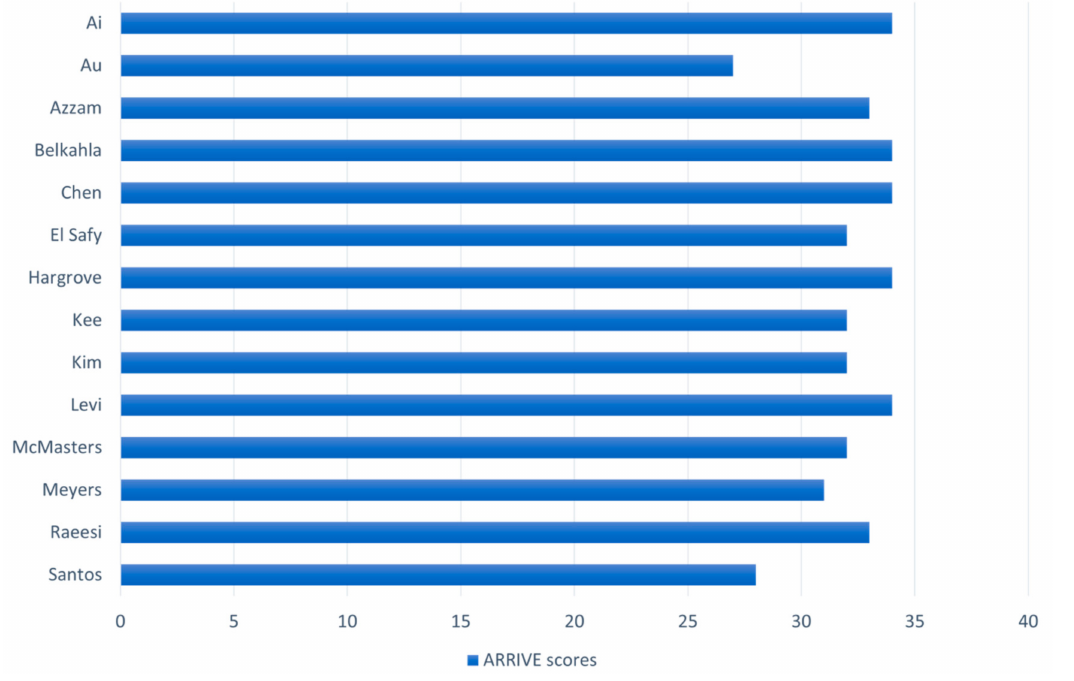
Figure 2. ARRIVE